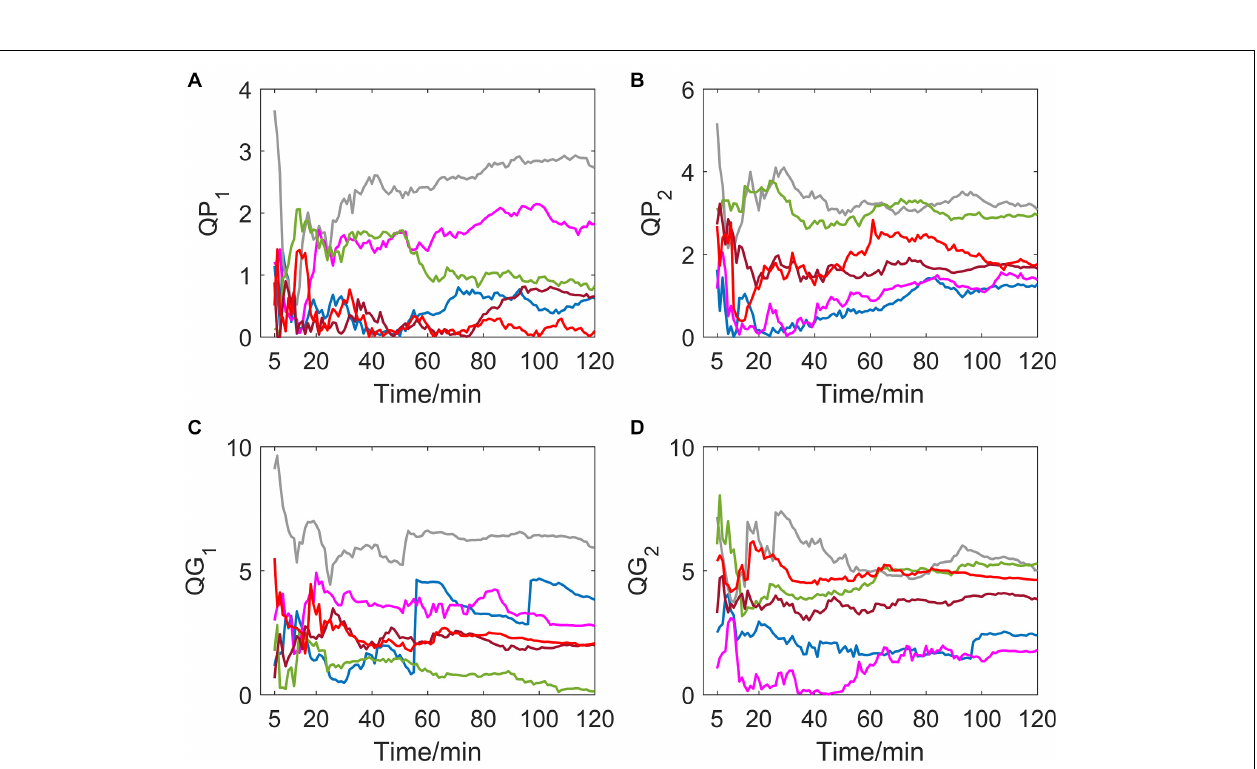
FIGURE 2 | (A–D) show the corresponding results of QP 1 , QP 2 , QG 1 , and QG 2 . Variation tendency of QP 1 , QP 2 , QG 1 , and QG 2 within 2 h of MIT normoxic group.